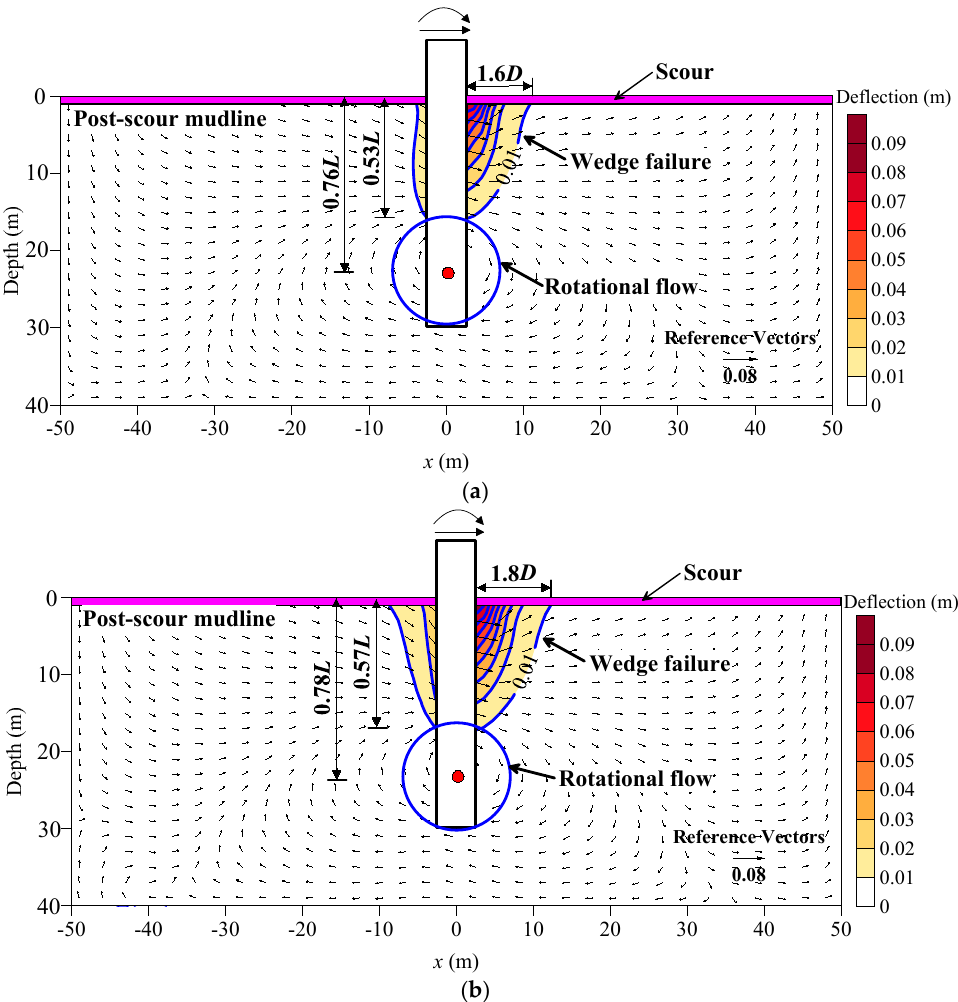
Figure 9. Computed soil displacement field and displacement vectors at the scour depth of S d = 0.2 D : ( a ) ignoring the stress history effect; ( b ) considering the stress history effect.